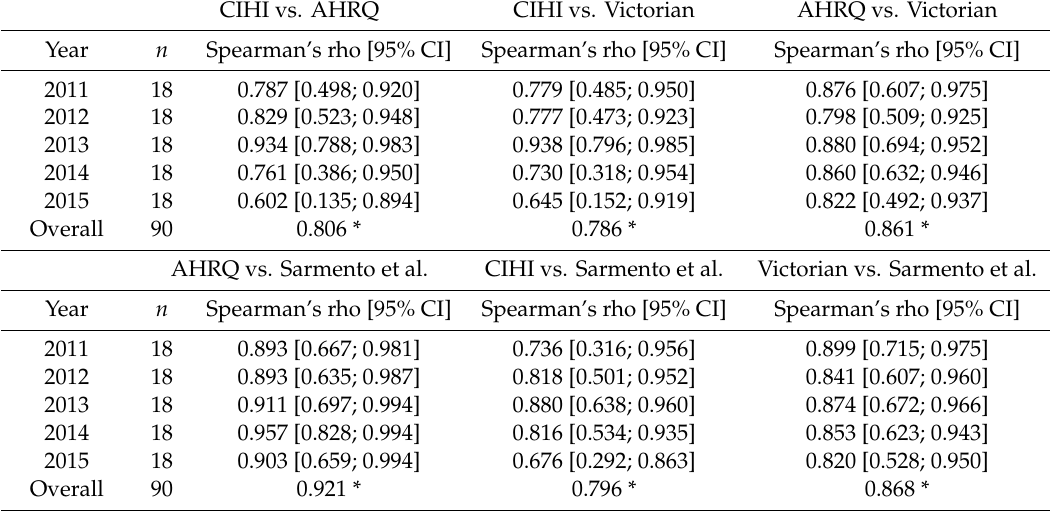
Table 4. The Correlation between Lists Assessed in Terms of Spearman’s